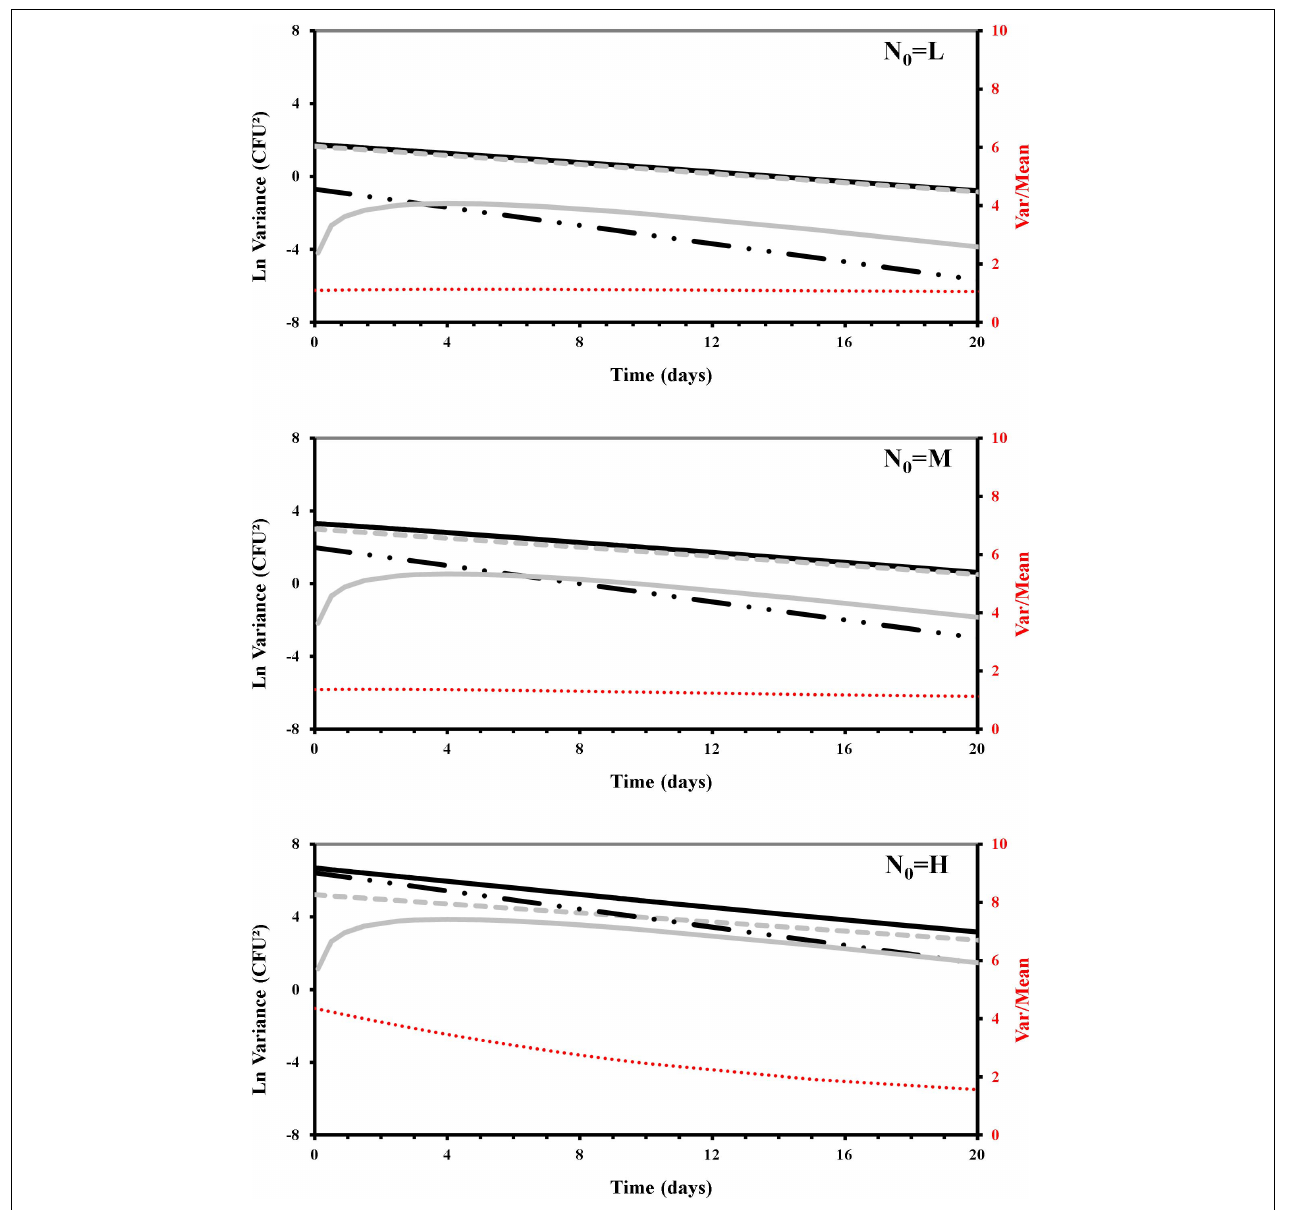
FIGURE 4 | Simulated contributors to variance of Listeria monocytogenes survivors during the osmotic treatment, starting with different initial cells (L, low cell density; M, medium cell density; H, high cell density). Total variance ( Var [ N t ] ): black solid line; Poisson variance E [N t ]: dashed gray line; non-randomness c 0 E [N t ] 2 : dashed black line; additional contribution (due to the osmotic treatment) to non-randomness ε t t E [N t ] 2 / E [N 0 ] 1 / 2 : gray solid line; variance over mean (secondary axis): dashed red line.